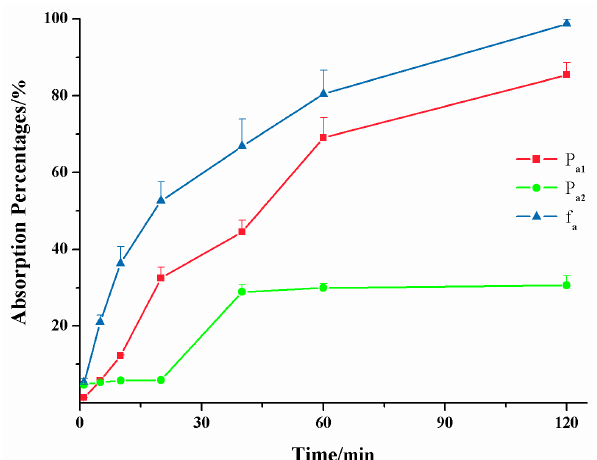
Figure 5. Absorption percentages of the lipid-based formulation of indomethacin from the new ex vivo lipolysis-absorption model ( ■ , P a1 ), the conventional everted gut sac model ( ● , P a2 ) and pharmacokinetics test of rats ( ▲ , f a ) within 2 h. ( n = 5).